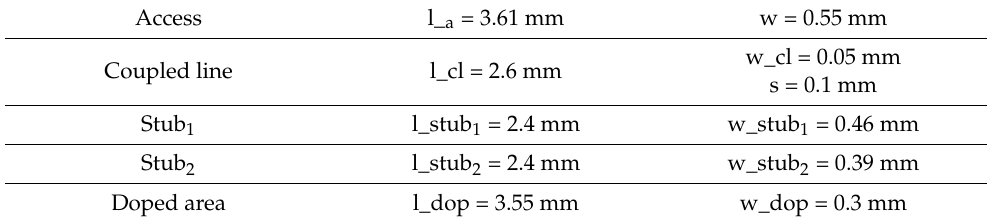
Table 7. Dimensions of the 10 GHz reconfigurable filter.